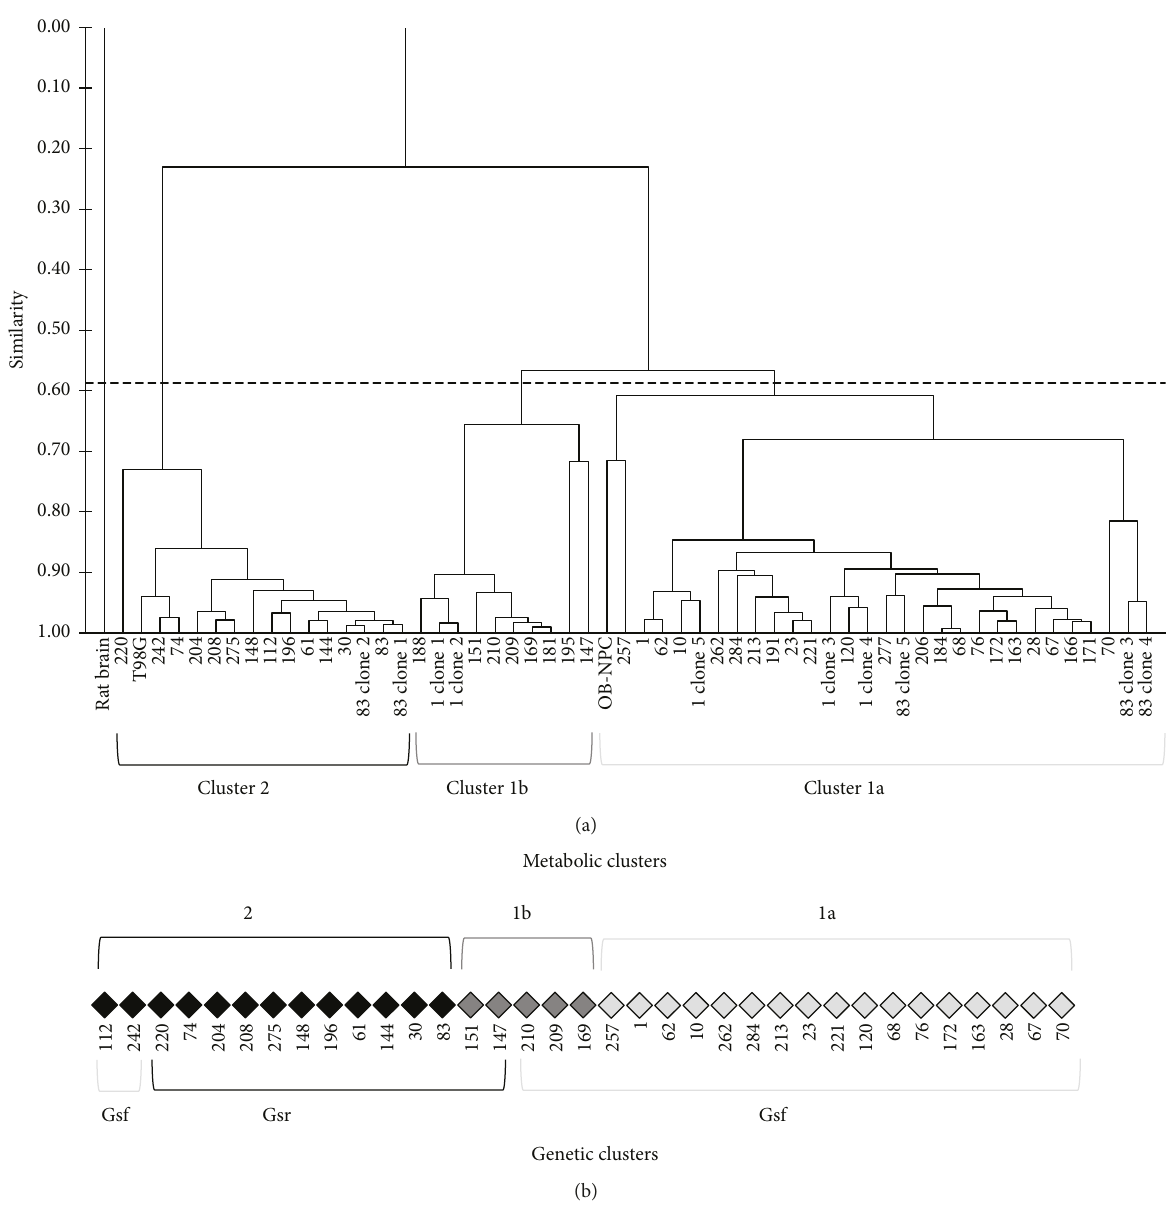
Figure 1: Metabolic clustering of GSCs. (a) Dendrogram resulting from unsupervised cluster analysis of metabolic data from MR spectra of rat brain, forty-four GSCs, OB-NPC, and T98G and fi ve clonal sublines of line #1 and fi ve of line #83. All samples were analyzed in triplicate. Cutting the dendrogram at an appropriate level, analysis allowed to separate tested cell lines into three clusters: 1a, 1b, and 2. Rat brain did not show any similarities with all other lines. (b) Comparison of metabolic and genetic clustering [11,